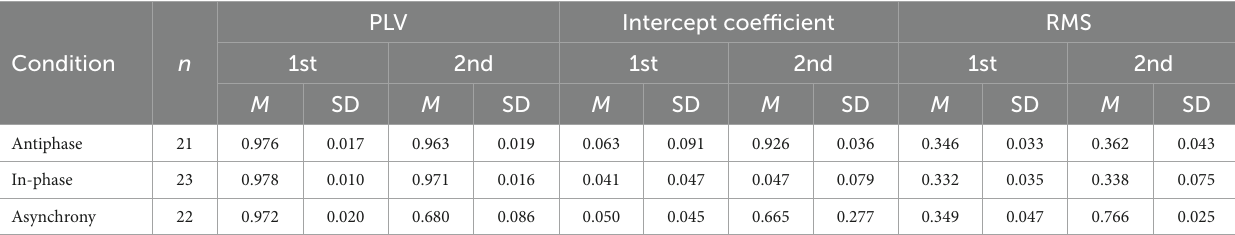
TABLE 1 Phase synchrony of the first and second session in each